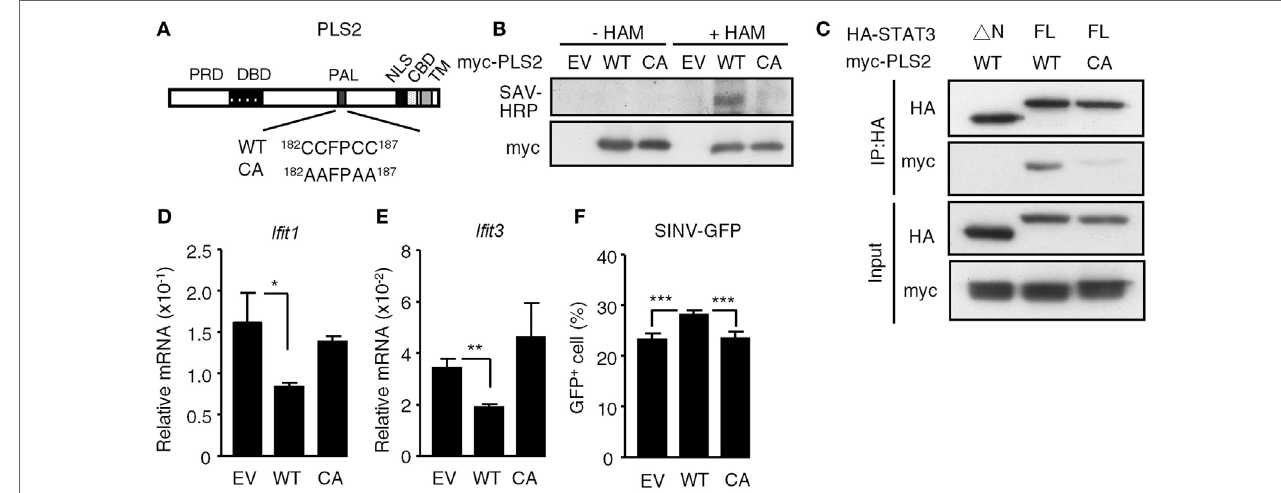
FigUre 5 | Palmitoylation of phospholipid scramblase 2 (PLSCR2) is required for interaction with STAT3 and for its suppressive effects. (a) Schematic diagram of WT and CA mutant of PLSCR2. Four conserved cysteine residues (CCFPCC) in the palmitoylation motif were changed to alanine residues. (B) HEK293T cells